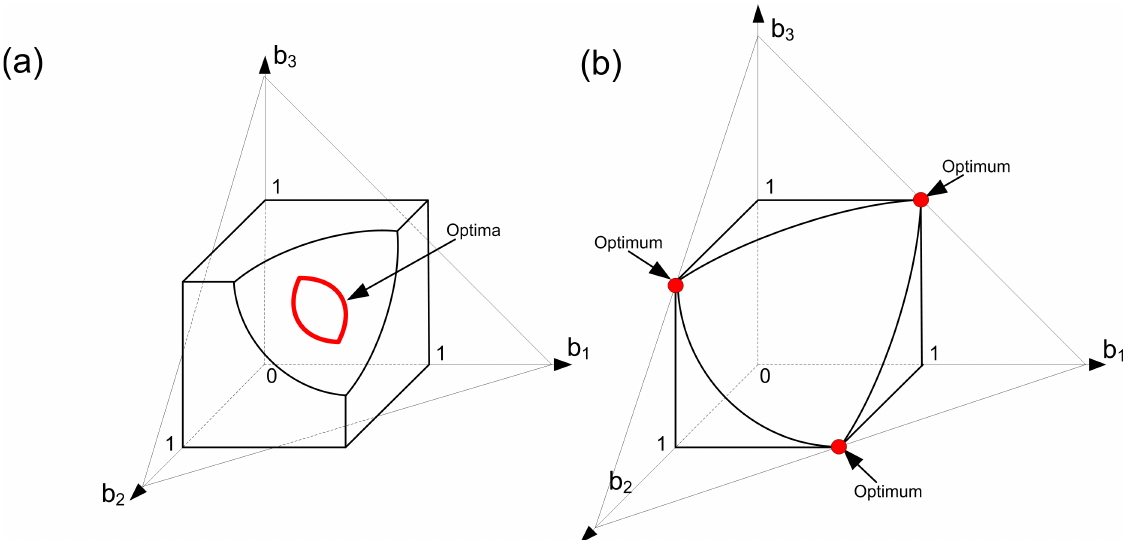
Fig 6. Evolution of germ and soma in colonies with identical cells: A concave trade-off, a resource constraint and different ‘importances’ of viability and fecundity (Case 2). Here we assume that we have three groups of cells within the colony such that all cells from each group have the same level of fecundity and the same level of viability (i.e., we have three ‘aggregate’ cells in the colony). Optimal strategies of the colony are colored in red. In panel (a) the optimal solutions represent a connected set (set A ) of unspecialized states that provides opportunities for adaptation for the colony at hand. In panel (b), the set A is a three-point set. The trade-off between the production difficulties and the fitness benefits of one fitness component (panel (b)) is one of the main reasons for the emergence of specialization in small-sized colonies. In both panels, α = 1, φ = 1- b 2 , k 1 = 2 and k 2 = 1. In panel (a), β = 0.5 and C = 5.5, In panel (b), β = 0.25 and C =